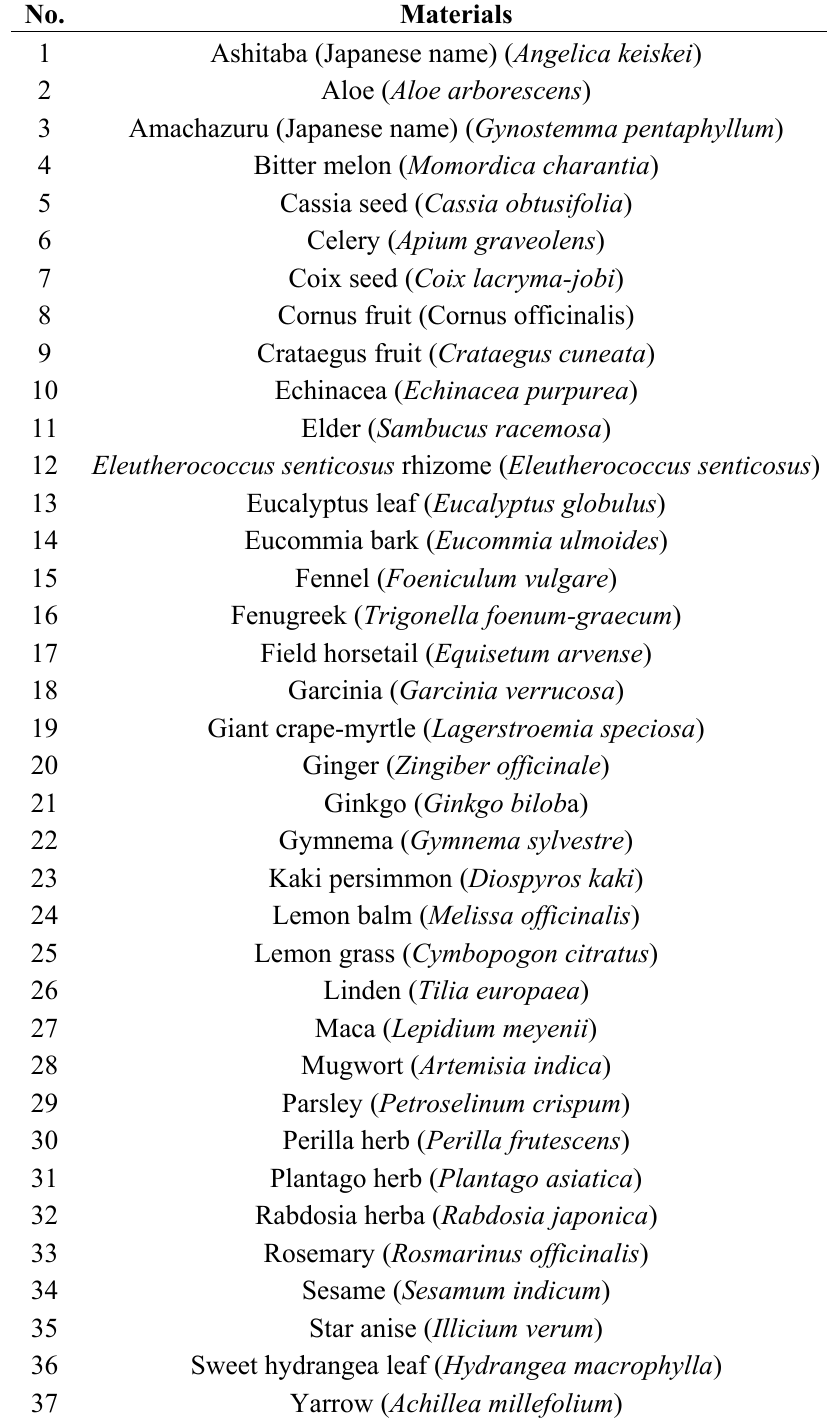
Table 1. List of health food materials used for the estimation of AhR activity